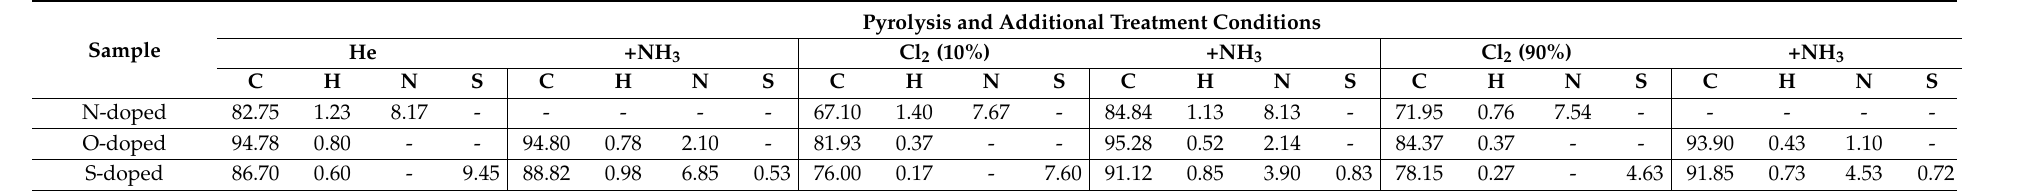
Table 5. Influence of pyrolysis conditions and additional ammonia annealing on the elemental composition (wt.%) of the obtained carbon materials.